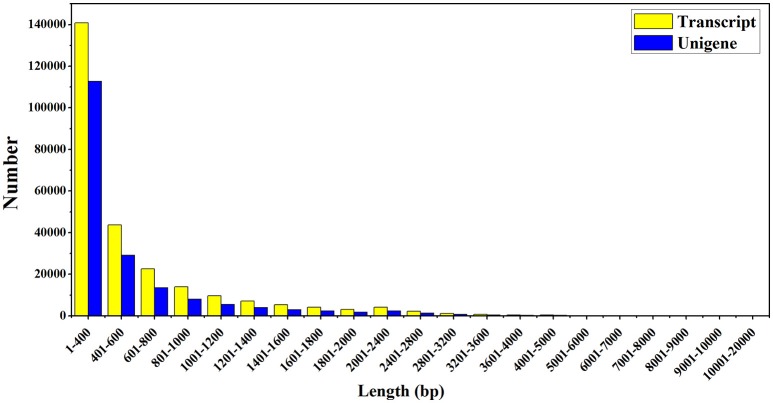
The sequence length distribution of assembled transcripts and unigenes. The horizontal and vertical axes respectively represent the different sequence length of base pairs and the number of assembled transcripts and unigenes relative to the sequence length.